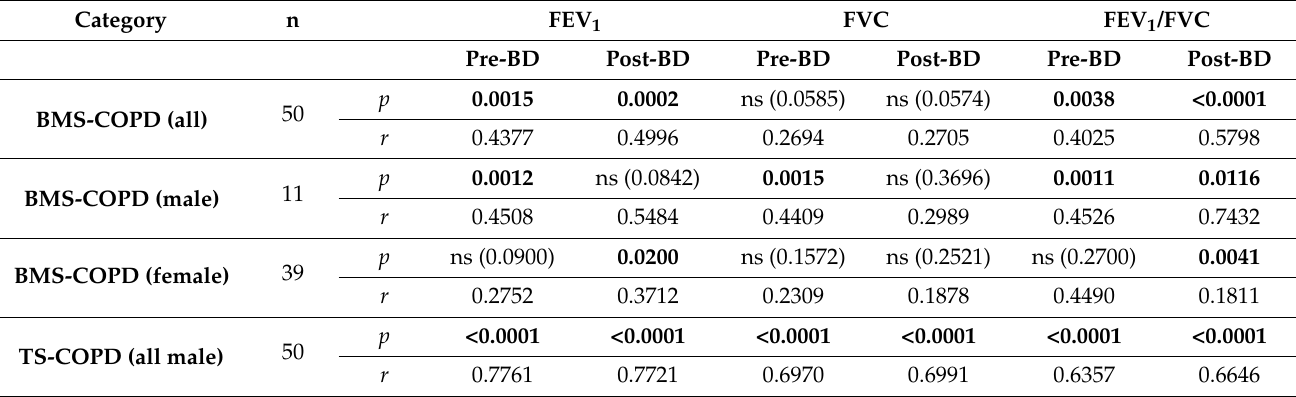
Table 2. Correlation of serum concentrations of secretoglobin family 1A member 1 (SCGB1A1) with pre-and post- bronchodilator (pre-BD and post-BD) test of forced expiratory volume in one second (FEV 1 % predicted), forced vital capacity (FVC % predicted), and FEV 1 /FVC among subjects with biomass smoke induced chronic obstructive pulmonary disease (BMS-COPD; male: 11, female: 39; total: n = 50) and tobacco smoke induced COPD ( n = 50, all male). Two tailed non-parametric Spearman’s rank test was used to analyze the correlation. p < 0.05 was considered as statistically